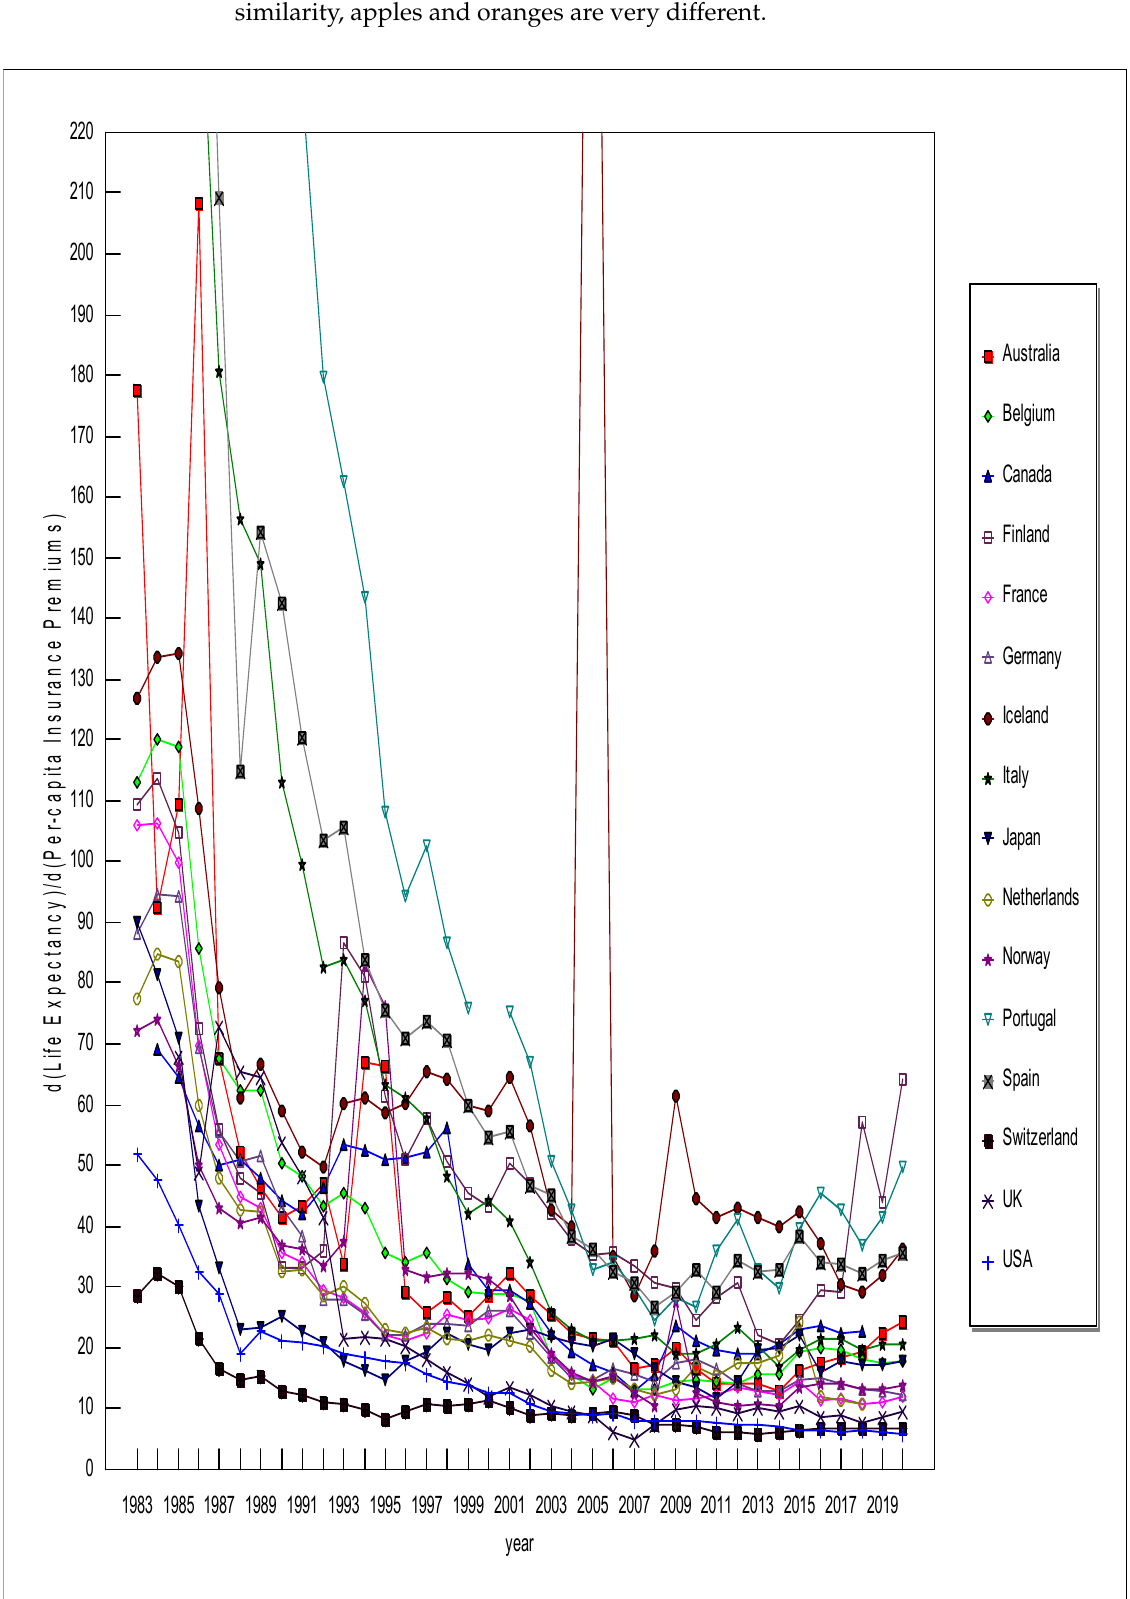
Figure 4. d (Life Expectancy in Days)/ d (Insurance Premiums Per Capita in US Dollars).